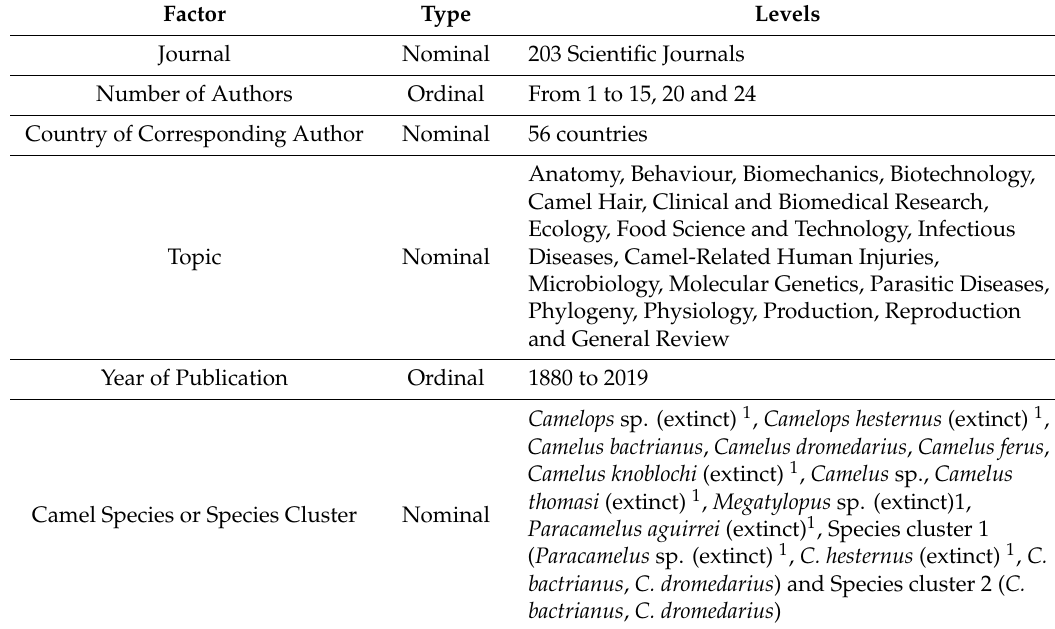
Table 1. Category description for conditioning factors considered to classify camel bibliography. Factor